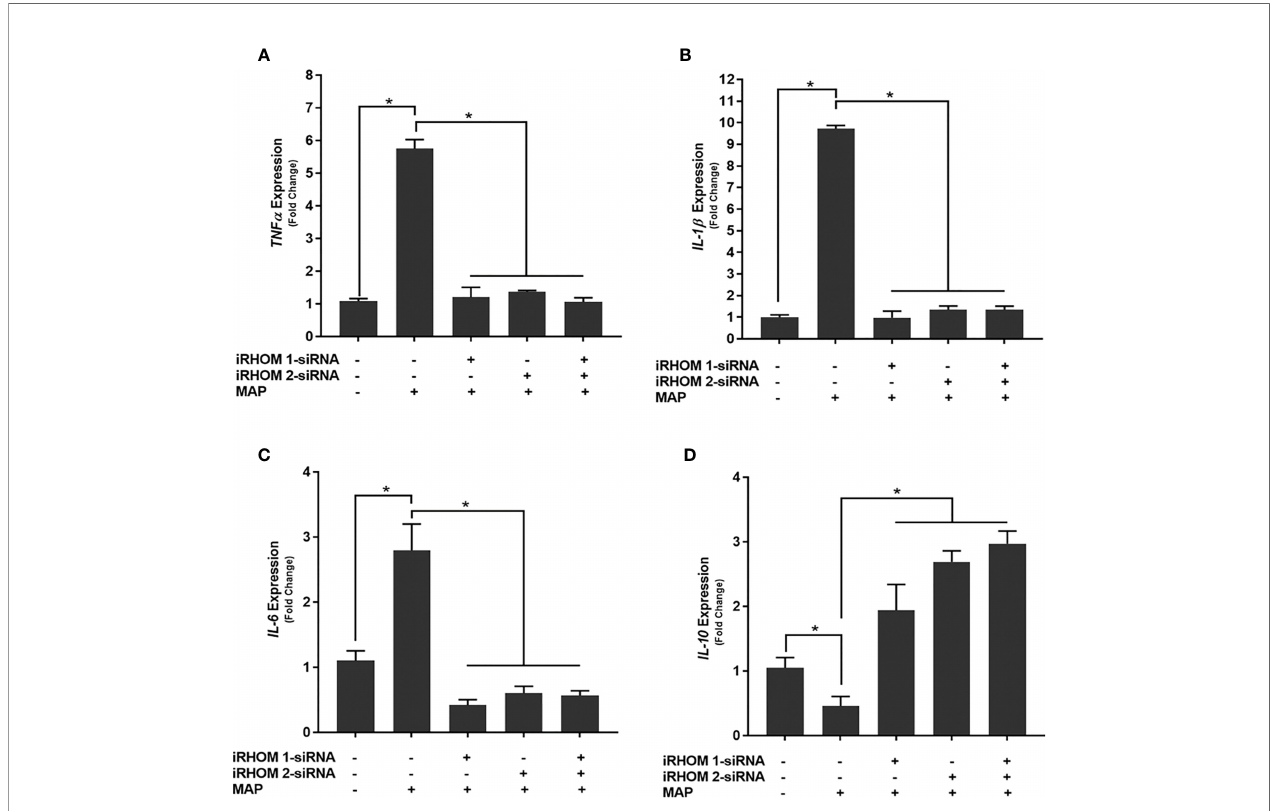
FIGURE 7 | The impact of TACE regression on the expression of (A) TNF a , (B) IL-1 b , (C) IL-6, and (D) IL-10. The Kolmogorov – Smirnov normality test was used to test the normal distribution for all values and a two-way analysis of variance (ANOVA) was used to assess signi fi cance among experiments, which was followed by a Bonferroni correction test. All experiments were performed in triplicates. *Indicates P-value of less than 0.05.